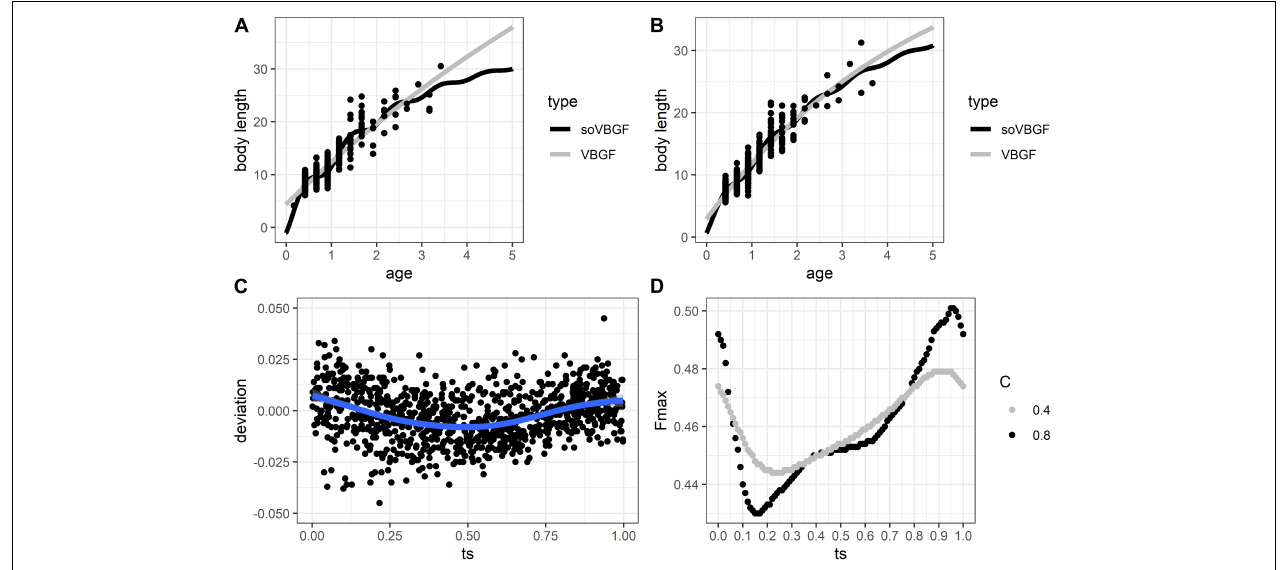
FIGURE 5 | (A) Fitting growth function by VBGF and soVBGF within dataset that display seasonal growth oscillation, the amplitude of seasonality is 0.8. (B) Similar plot with panel (A) except that the amplitude of seasonality is 0.4. (C) Scatterplot of the deviation caused by ignoring seasonality. Full line indicates trend line generated by generalized additive models (GAMs). (D) Deterministic estimation of reference point F max for H. otakii under different ts . Black points and gray points indicate that C is 0.8 and 0.4,